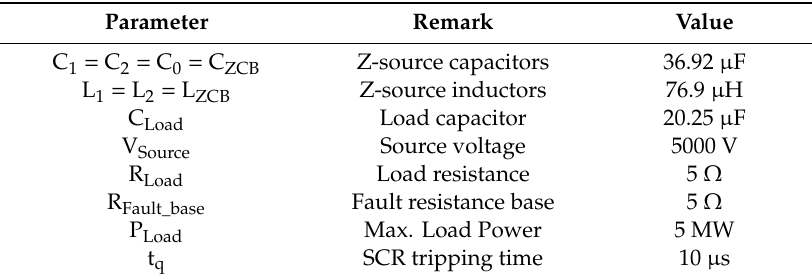
Table 4. Specified parameters of the simulation system.